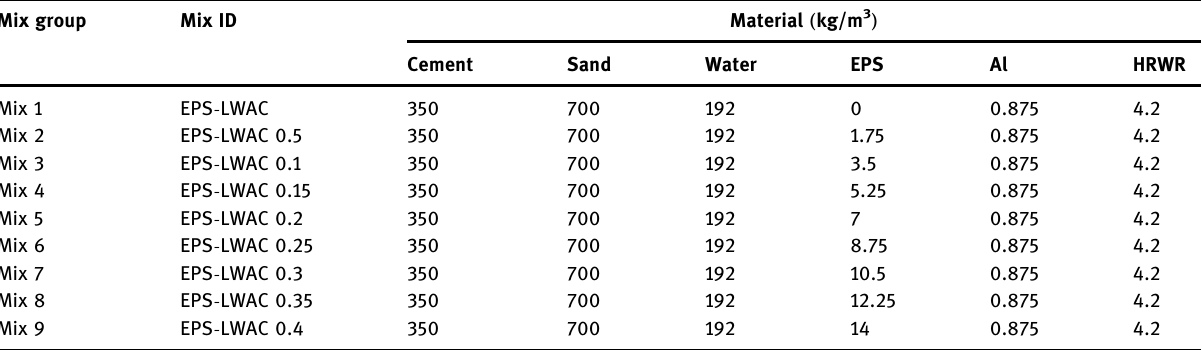
Table 4: Mix details of EPS - AC